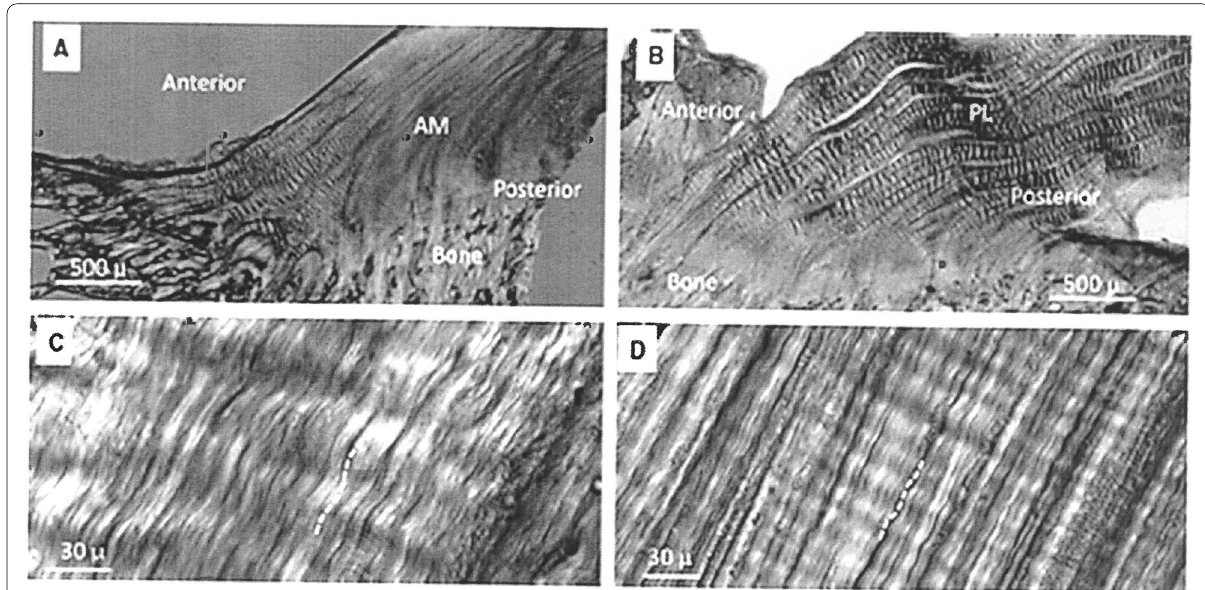
Fig. 2 A Crimping in the anteromedial (AM) ACL bundle; B Crimping in the posterolateral (PL) bundle; Coarse crimps are visible in the